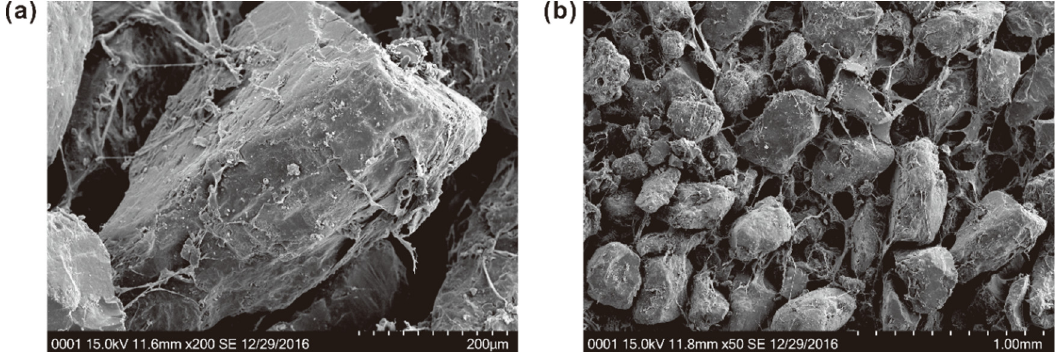
Figure 10. SEM images of sand treated with PU: ( a ) interaction characteristics between polymers and sand particles; ( b ) Internal microstructure of treated sand.